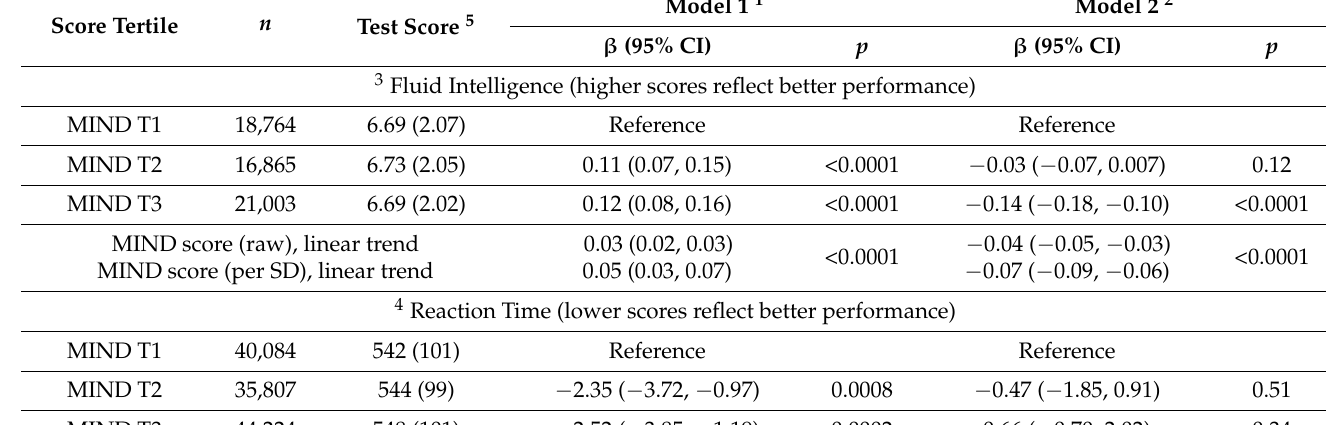
Table 3. Associations between adherence to MIND and cognitive